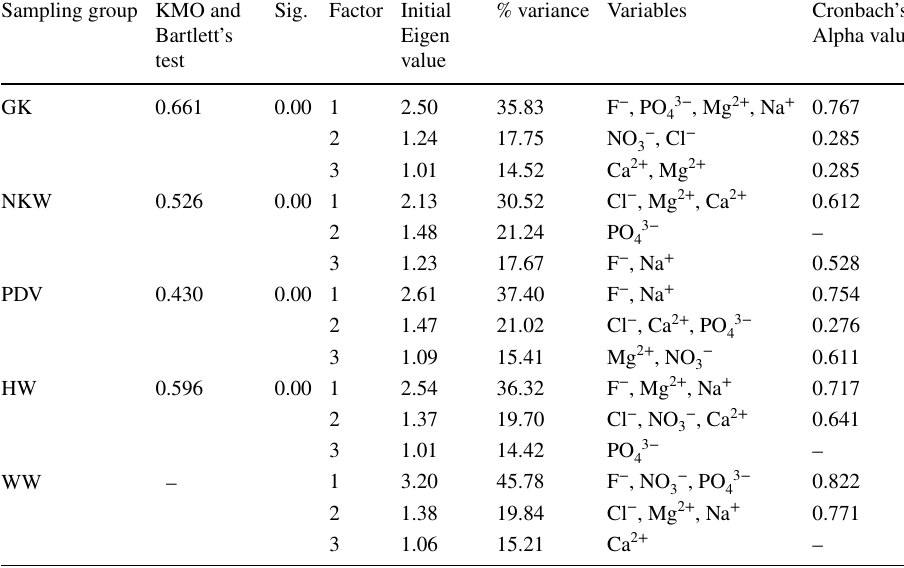
results summary for secondary data